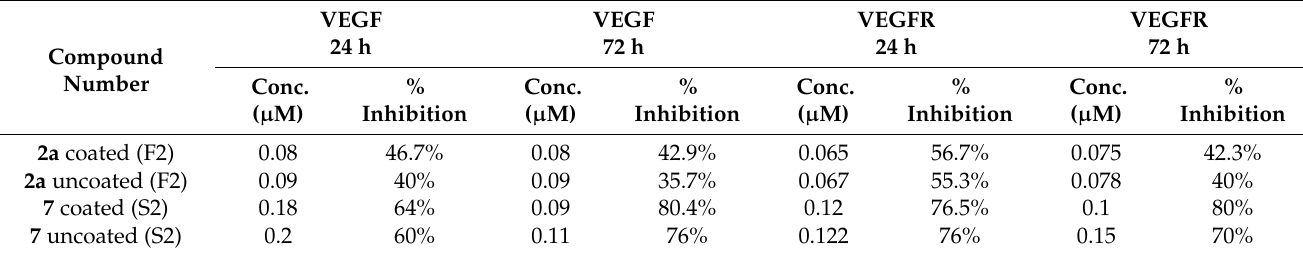
Table 10. Effects of 2a - and 7 -loaded niosomes (F2 and S2) either coated with TPGS versus the uncoated ones in the HepG2 cell line compared to the control using ELISA as the percentage of inhibition.